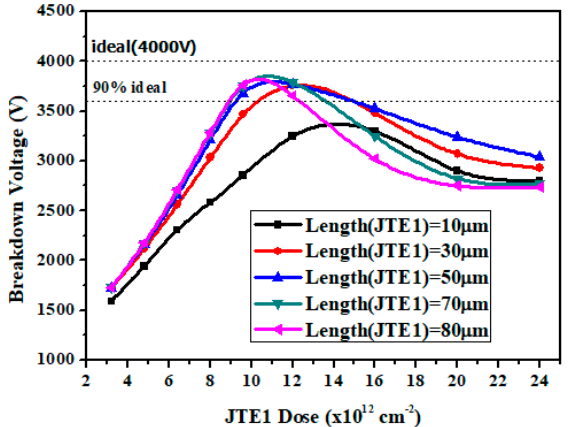
Figure 4. Simulated BV versus JTE1 length with different doses for the DZ-JTE optimization.